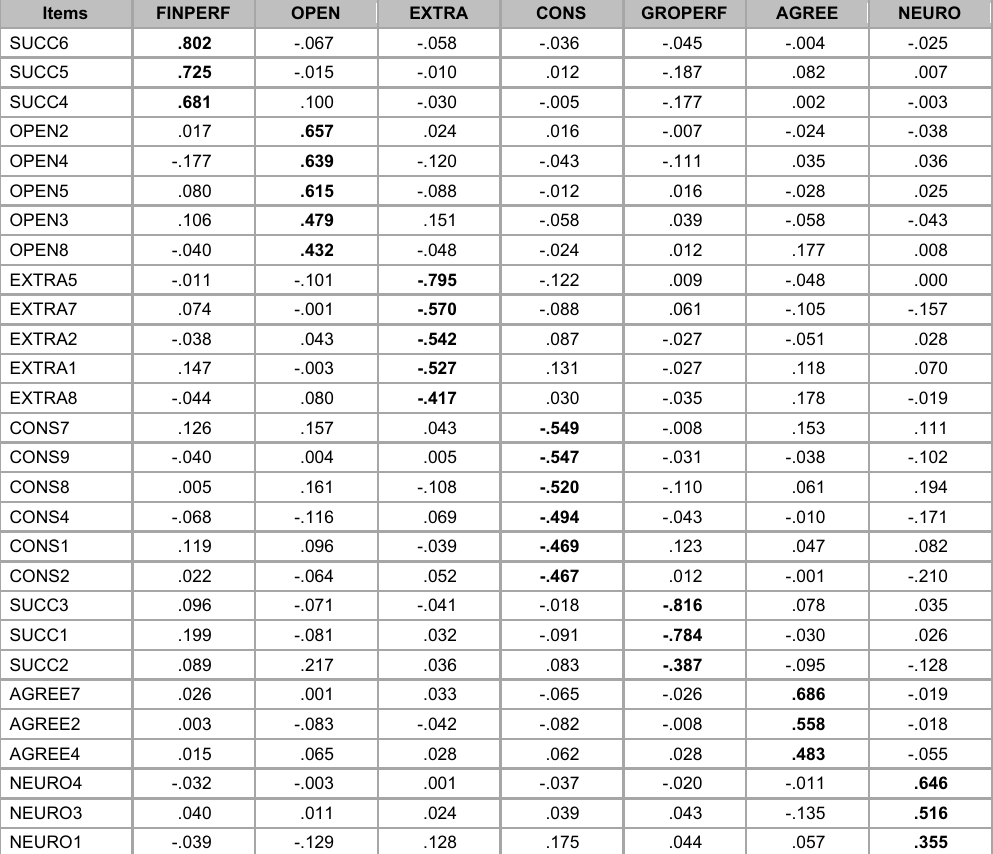
Results of the factor analysis (rotated factor